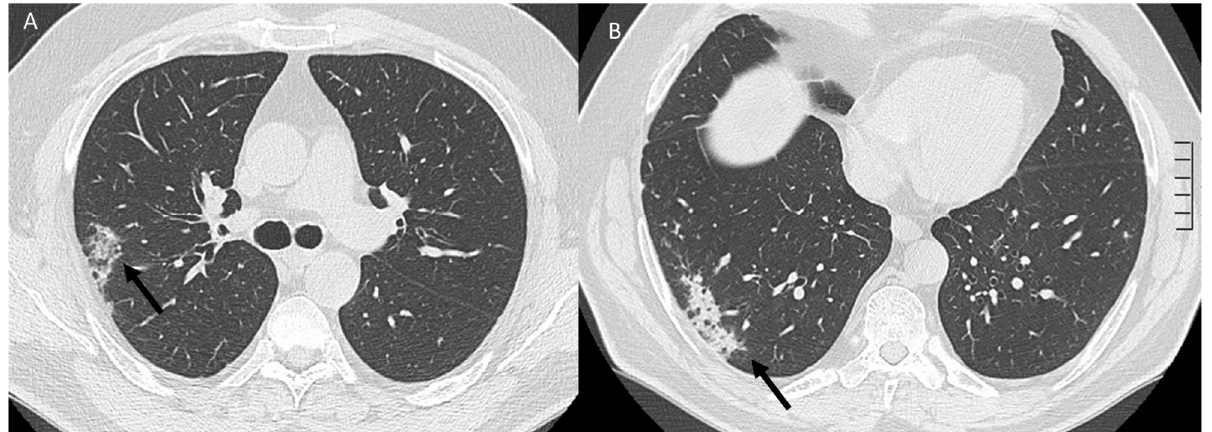
Figure 8. CT evaluation ( A , B ) of RRP induced by COVID-19 vaccine in RT-treated patients with lung metastases: consolidative pattern (arrows).